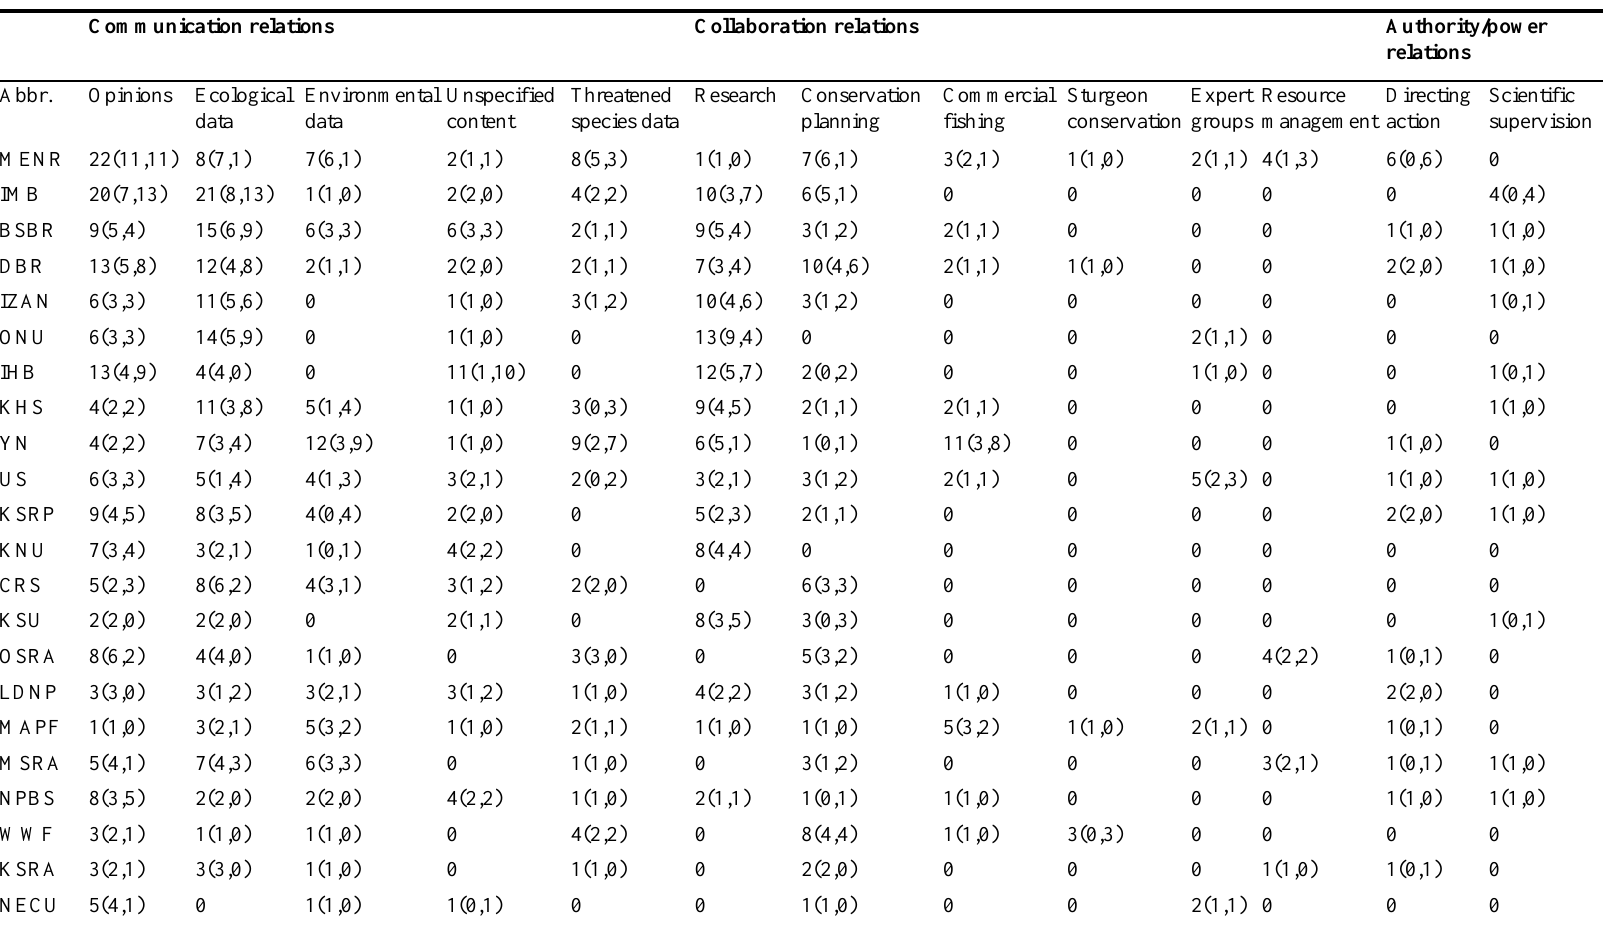
Table A2.2. Number of mentioning of interaction themes by individual stakeholders. Values between brackets represent No. times the theme characterized the incoming ties and No. times the theme characterized the outgoing ties. Communication relations